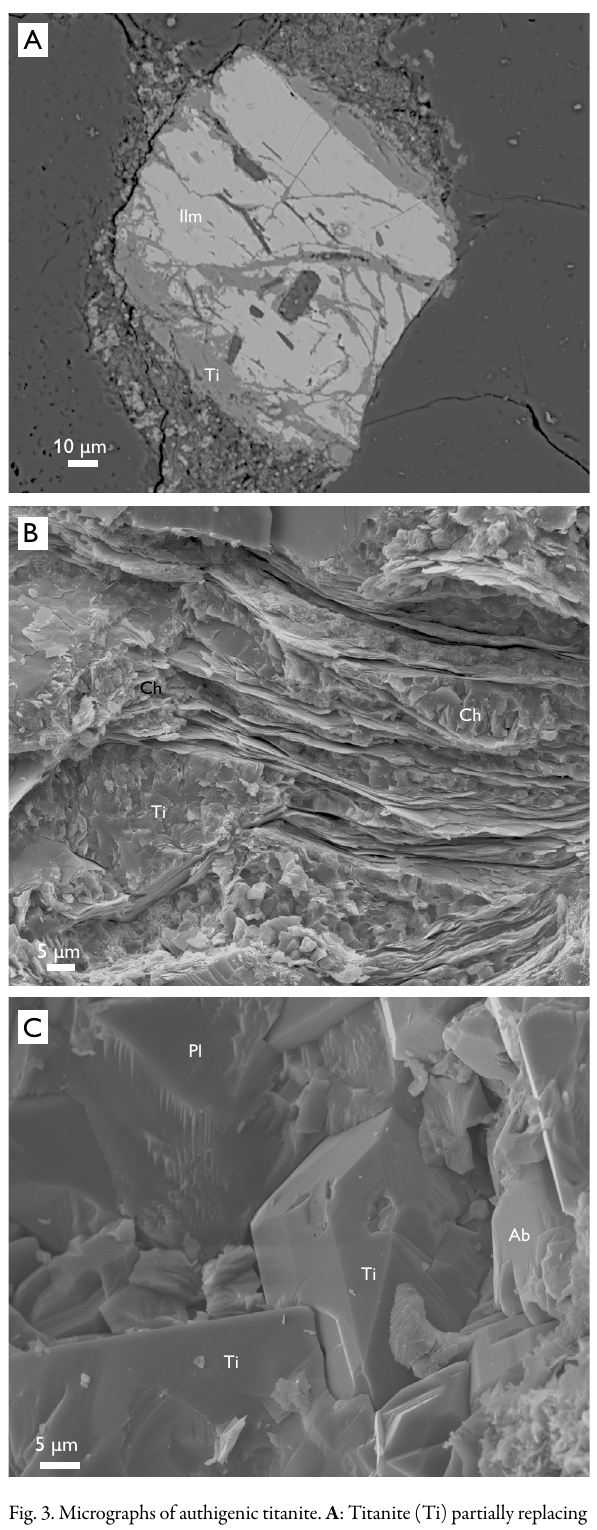
Fig. 3. Micrographs of authigenic titanite. A : Titanite (Ti) partially replacing an ilmenite (Ilm) grain (intra-basaltic sandstone; BSE micrograph). B : Titanite and chlorite (Ch) precipitated between the cleavage planes in mica (intra-basaltic sandstone; SE micrograph). C : Titanite intergrown with albite (Ab) and Ca-rich plagioclase (Pl; intra-basaltic sandstone; SE